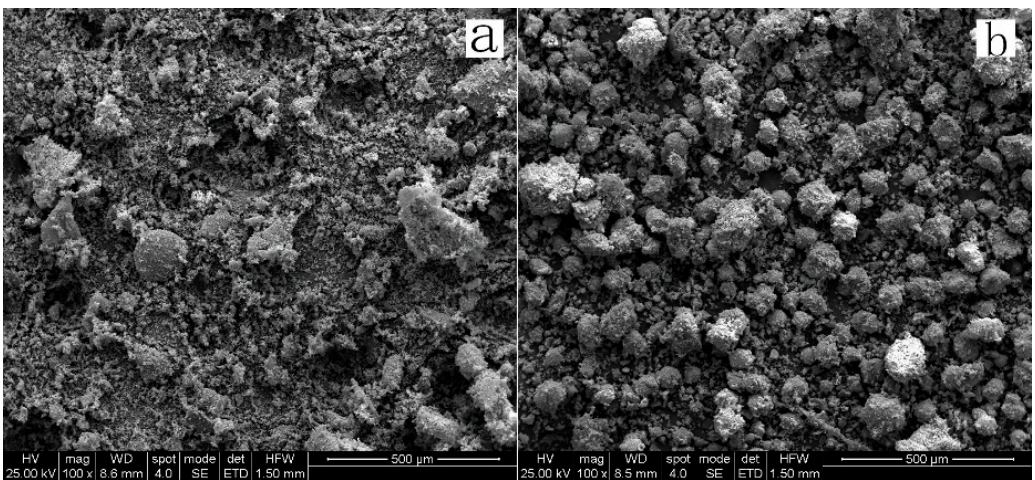
Figure 16. SEM images of residues ( a ) leaching time 0.5 h; ( b ) leaching time 2.5 h.